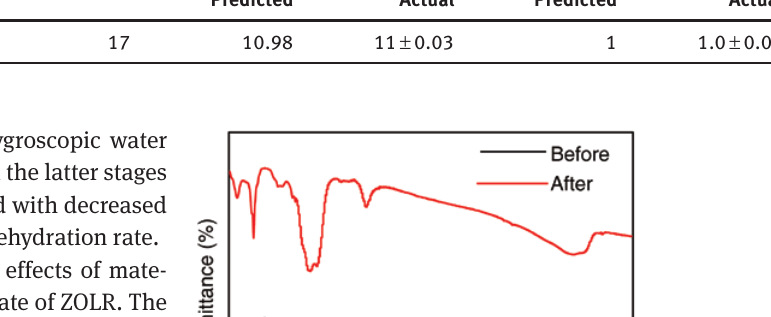
Table 6: Predicted and experimental values at optimum conditions. Temperature